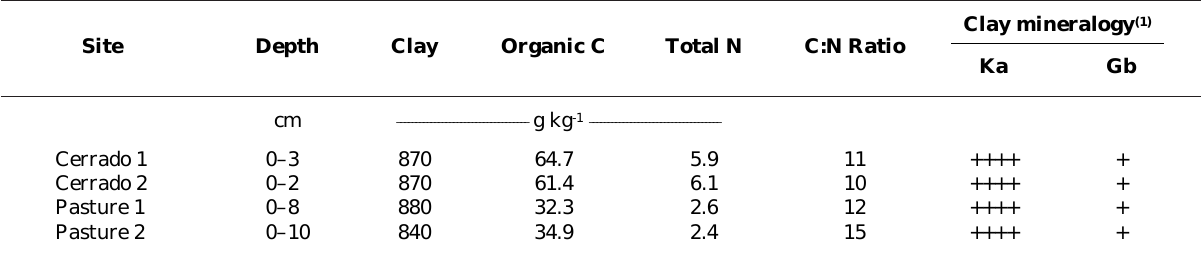
Table 1. Properties of the topsoils of a Typic Haplustox (Latossolo Vermelho distrófico típico under cerrado and